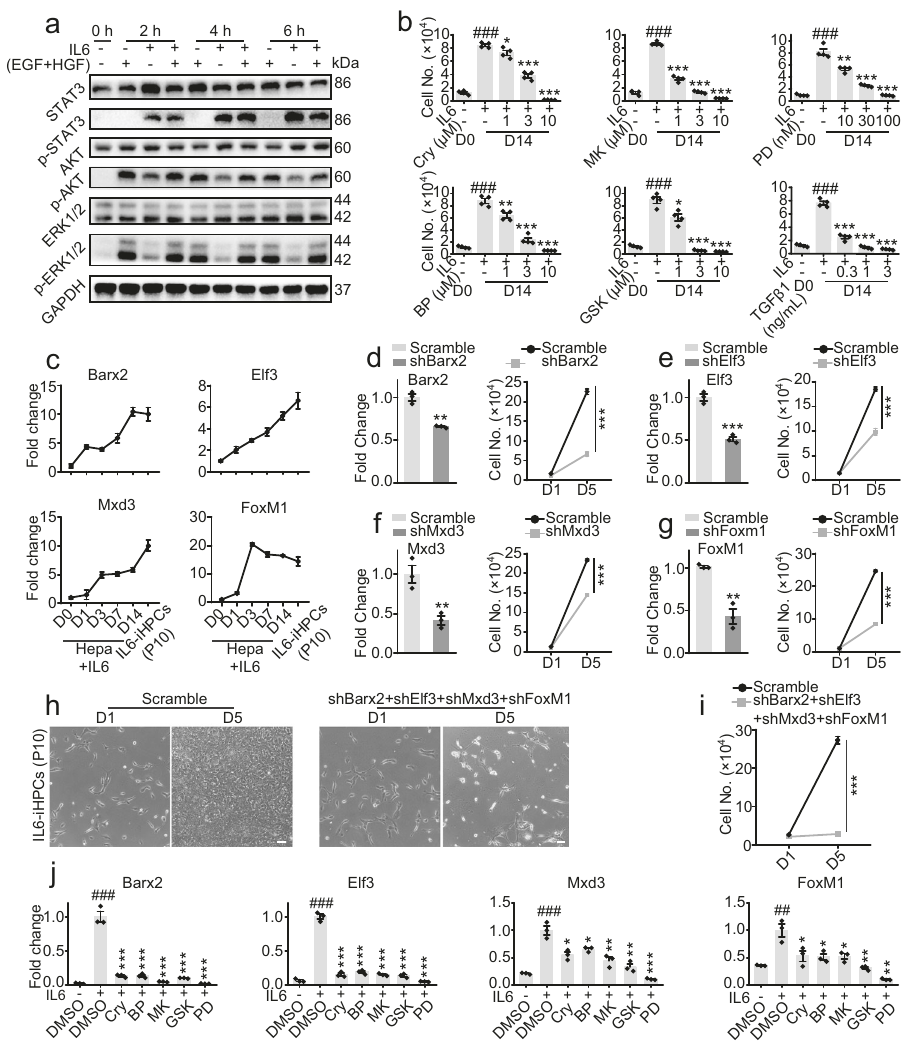
Fig.6|SignalpathwaysandTFsinvolvedinIL6-inducedhepatocyteexpansion. a Western blot analysis of STAT3, p-STAT3, AKT, p-AKT, ERK1/2, p-ERK1/2 in hepatocytestreated withIL6,EGF/HGForthe combinationfor2,4and 6h.GAPDH was used as loading control. b Cell numbers of hepatocytes cultured in